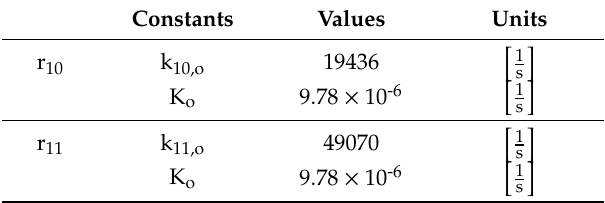
Table A2. Experimental parameters for the rate law for acrylic acid formation